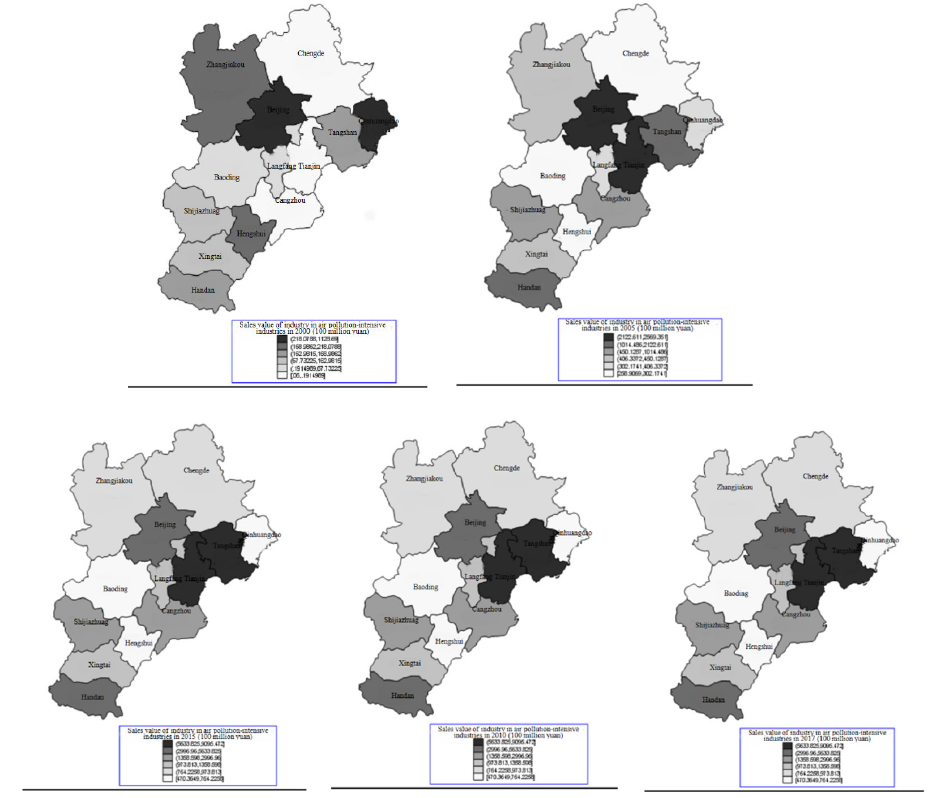
Figure 1 Spatial Quantile ‐ Quantile Plot of sales value in Beijing ‐ Tianjin ‐ Hebei high haze pollution Figure 1.